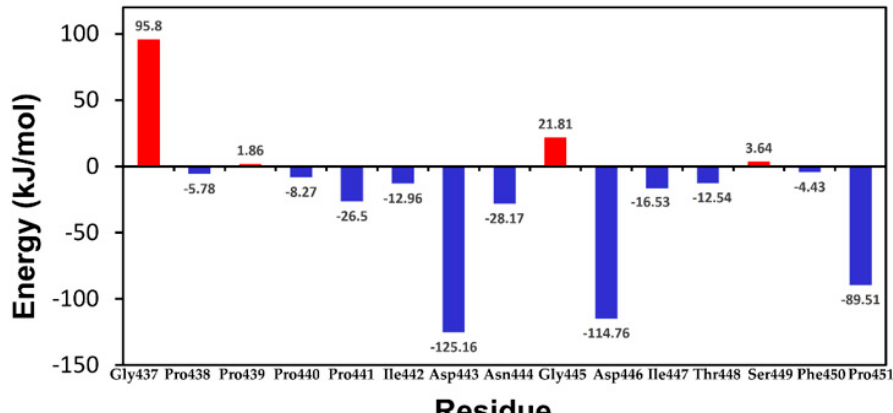
Figure 4. Amino acid energy decomposition of pCFH. The red bar or the blue column indicates the binding energies positive or negative respectively after the substitution. The smaller the Amino acid energy decomposition value (kJ / mol), the greater the contribution of this amino acid to the binding of antigen to antibody.